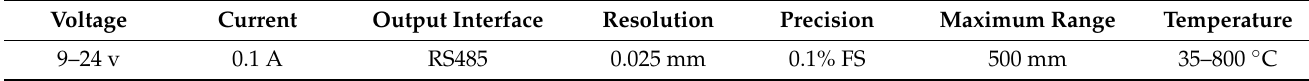
Figure 2. High-precision and large-range cable displacement sensor.